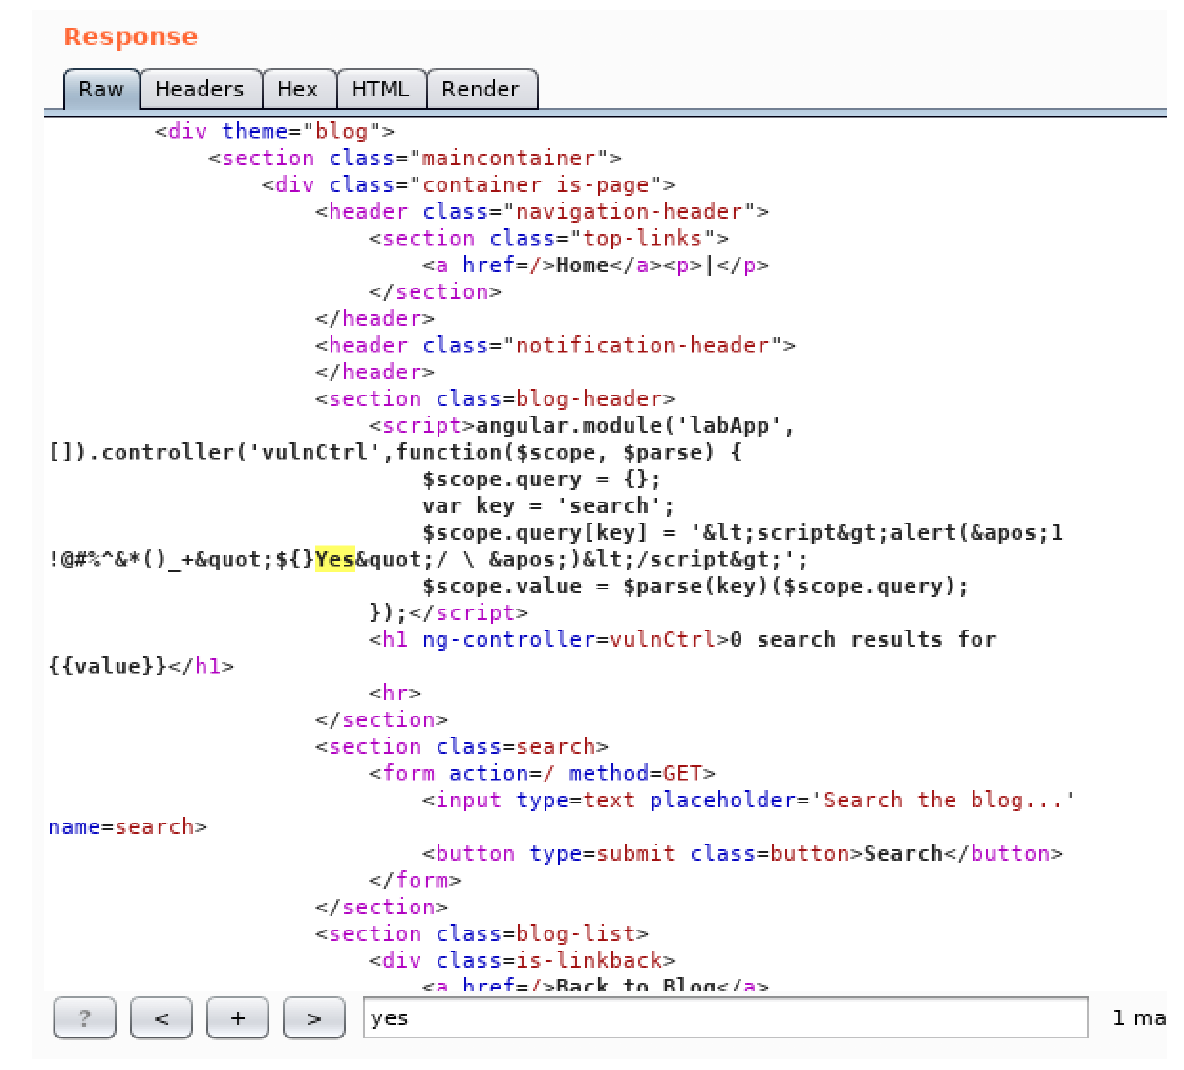
Figure 3. Escaping AngularJS